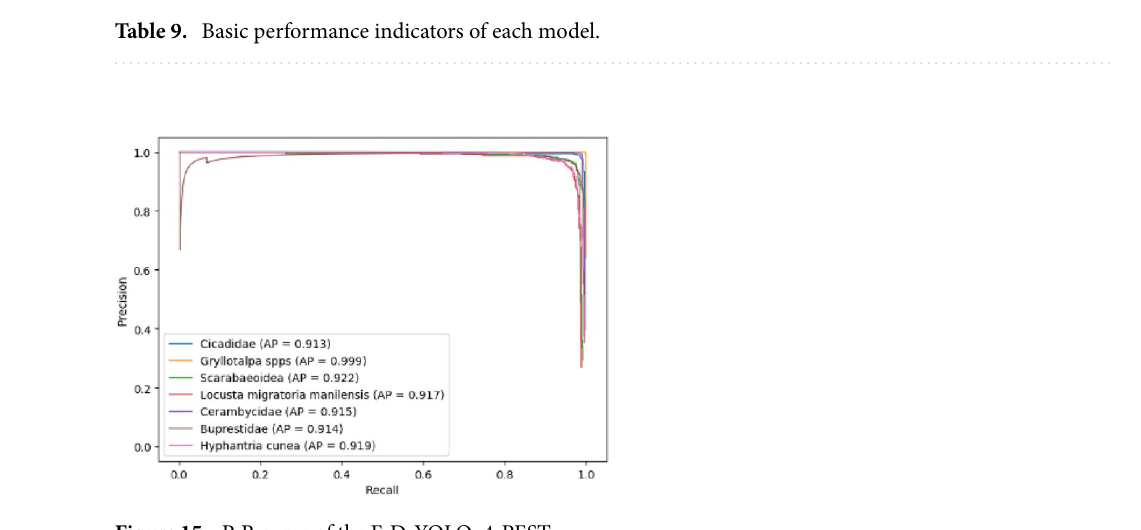
Figure 15. P-R curve of the